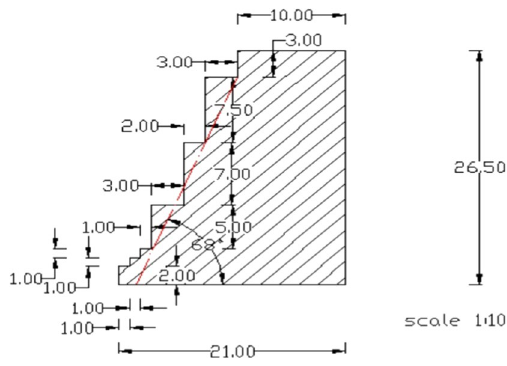
Fig. 6 Stepped weir side view, scale 1:10, all dimensions in cm